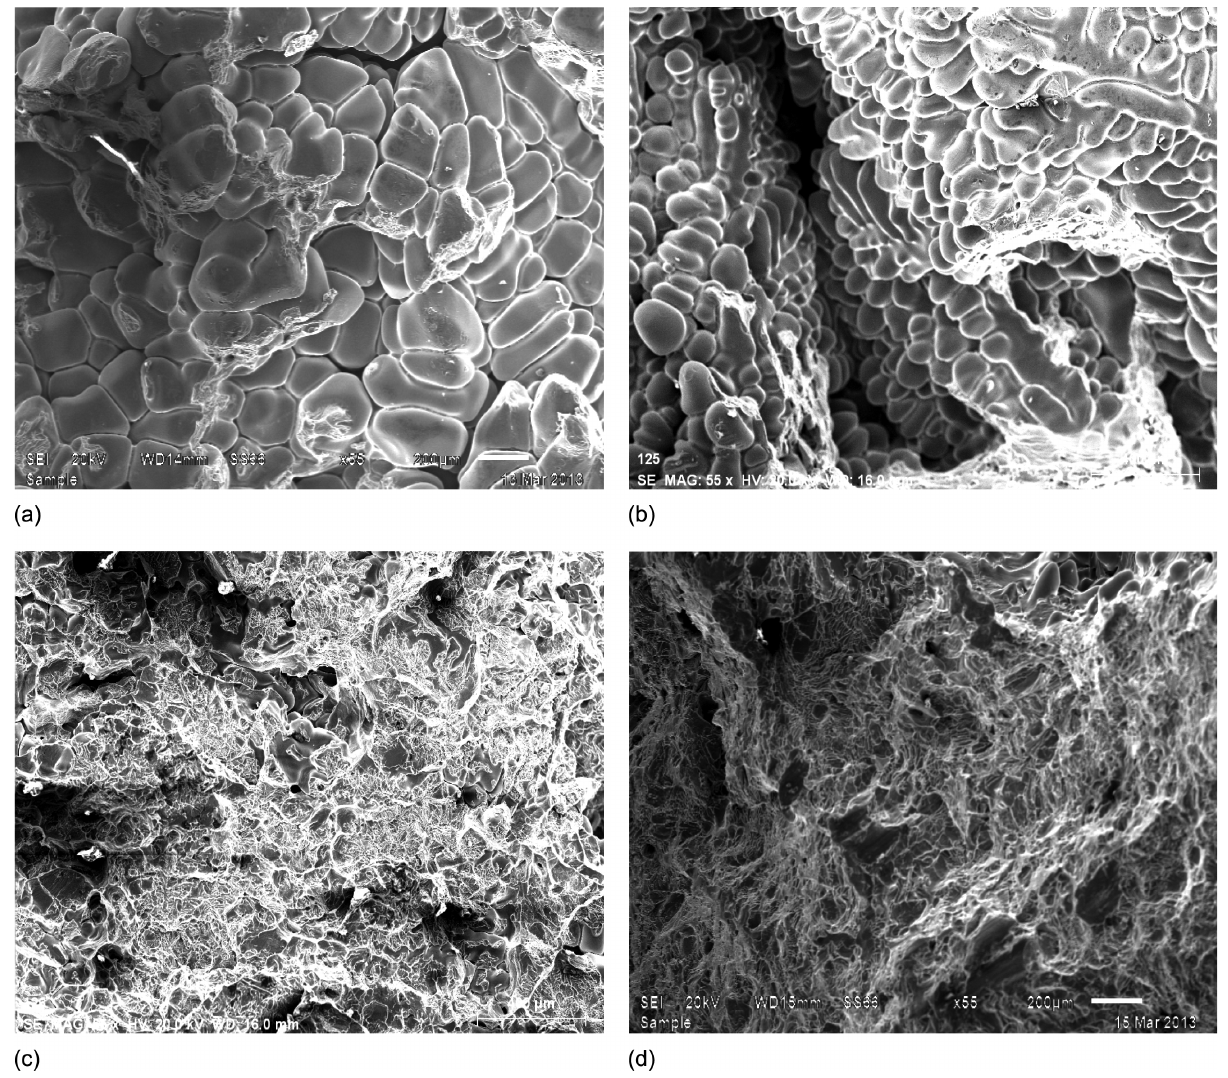
Fig. 1: (a) Scanning micrograph of Al. (b) Scanning micrograph of Al composite with 15 wt% of SiC. (c) Scanning micrograph of Al composite with 30 wt% of SiC. (d) Scanning micrograph of Al composite with 15 wt% of SiC and 1 wt% of